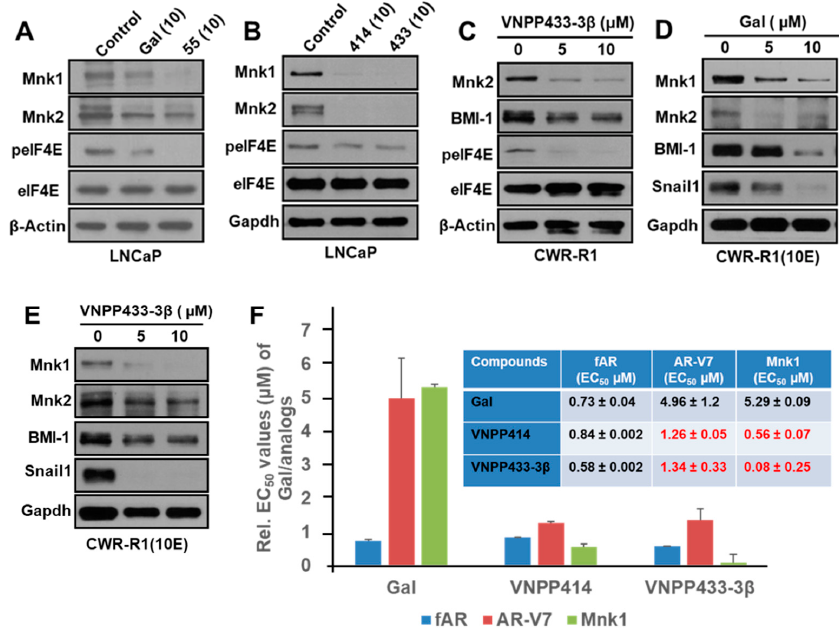
Figure 4. Impact of Gal and NGGAs on AR/AR-V7 and Mnk1/2-eIF4E signaling pathways. ( A ) Western blot showing the effects of Gal and VNPT55 (55) on Mnk1, Mnk2, and peIF4E. ( B ) Western blot showing the effects of VNPP414 (414) and VNPP433-3 β (433)) on Mnk1, Mnk2, and peIF4E. ( C ) Western blot showing dose-dependent effect of VNPP433-3 β (433) on Mnk2, BMI-1, and peIF4E in CWR-R1 cells. ( D ) Western blot showing dose-dependent effect of Gal on Mnk1, Mnk2, BMI-1, and Snail1 in drug-resistant CWR-R1(10E) cells. ( E ) Western blot showing dose-dependent effect of VNPP433-3 β (433) on Mnk1, Mnk2, BMI-1, and Snail1 in drug-resistant CWR-R1(10E) cells. ( F ) EC 50 values (for fAR, ARV-7 and Mnk1) for compounds determined from dose–response curves upon compound treatments (0–7.5 µ M) of CWR22Rv1 cells for 72 h followed by western blot analysis of cells lysates. Note: the numbers in parentheses in Figure 4B are concentrations of the agents in µ